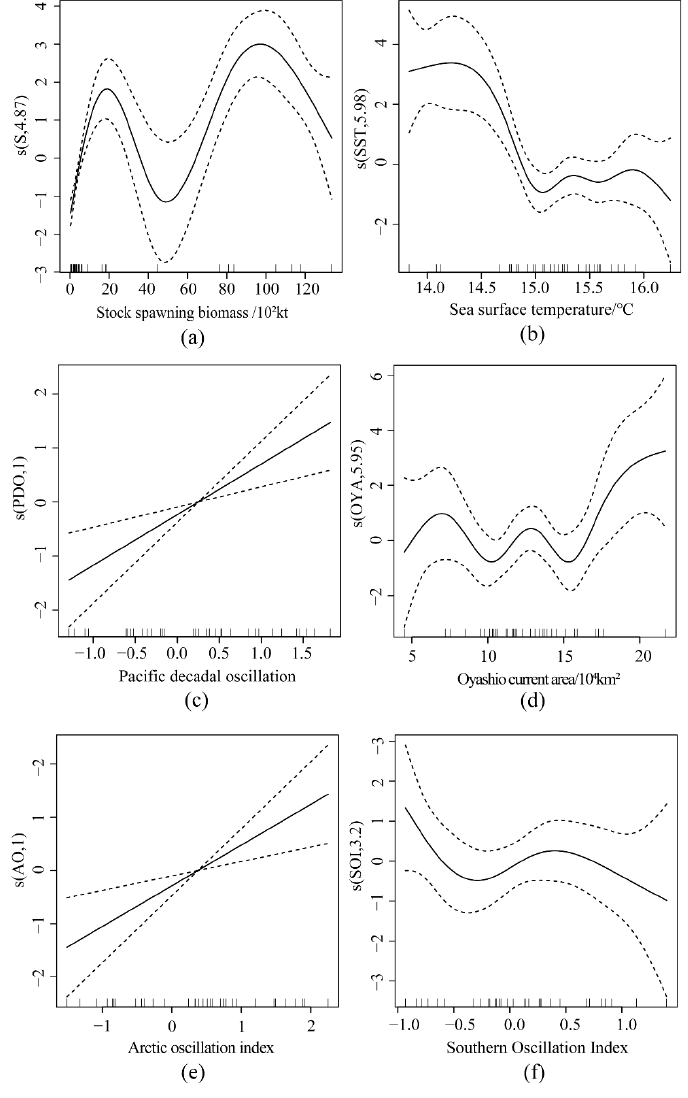
Figure 6. GAM single factor fitting residual diagram (dashed parts are confidence intervals). ( a ) Residuals of stock spawning biomass; ( b ) Residuals of sea surface temperature; ( c ) Residuals of Pacific decadal oscillation; ( d ) Residuals of Oyashio Current; ( e ) Residuals of Arctic Oscillation Index; ( f ) Residuals of Southern Oscillation Index.